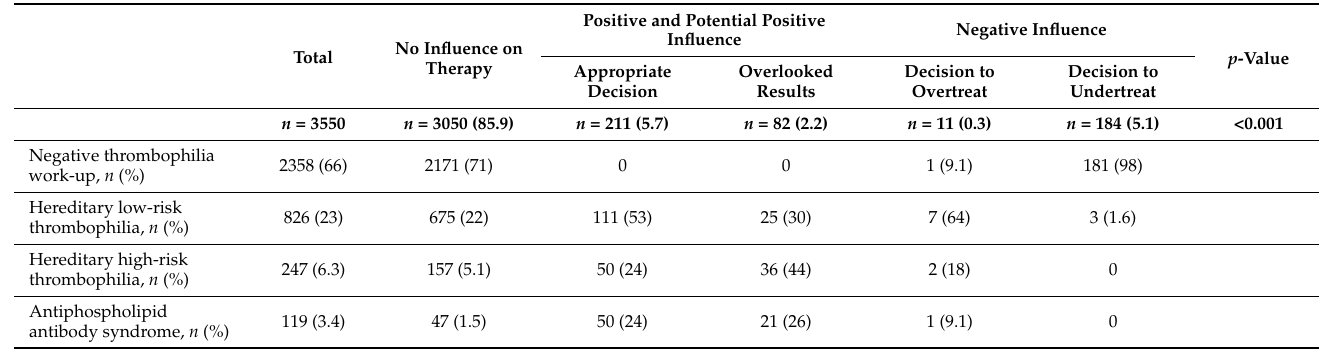
Table 3. Influence of thrombophilia work-up on treatment decision.